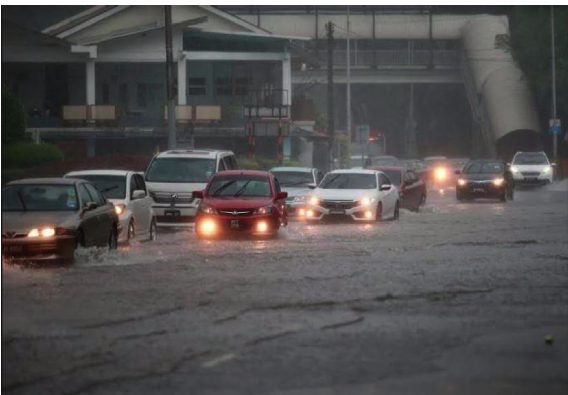
Figure 3: Road flood disasters registered in